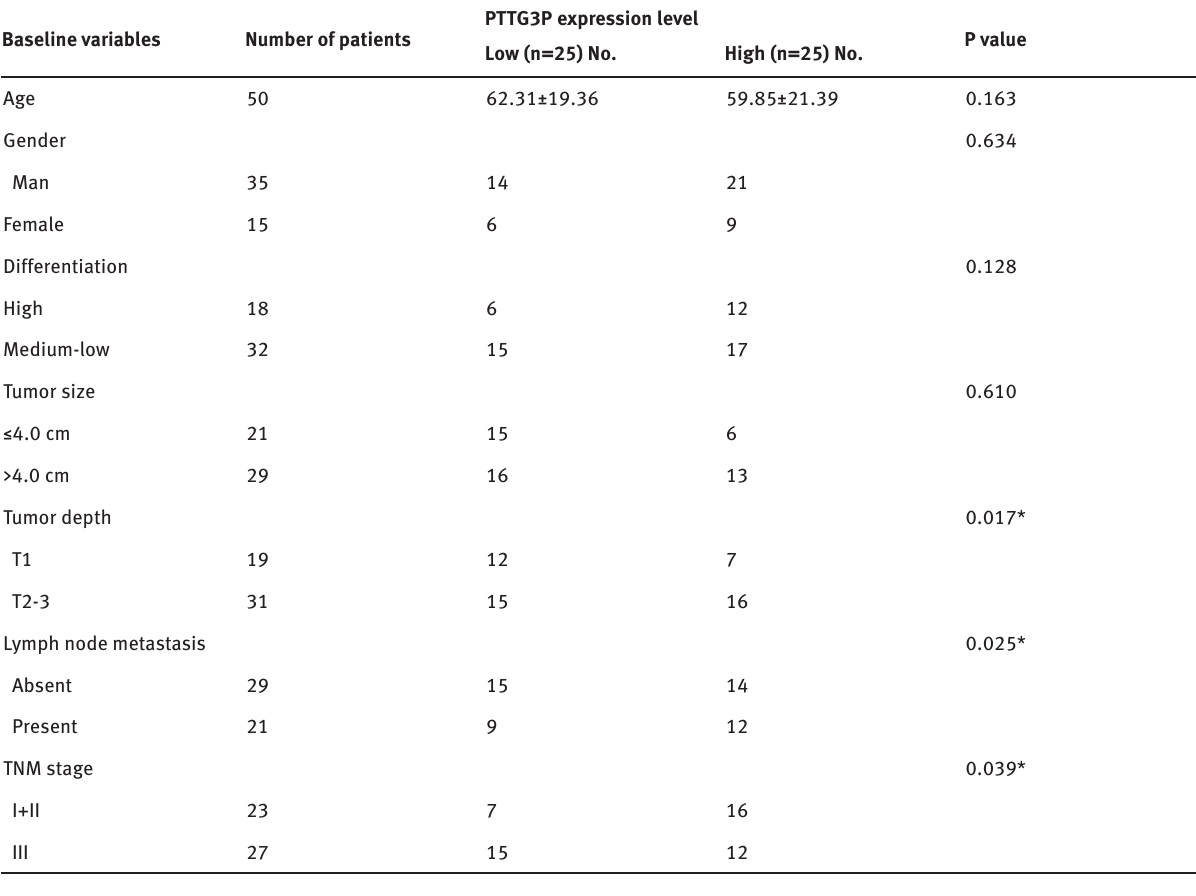
Baseline variables